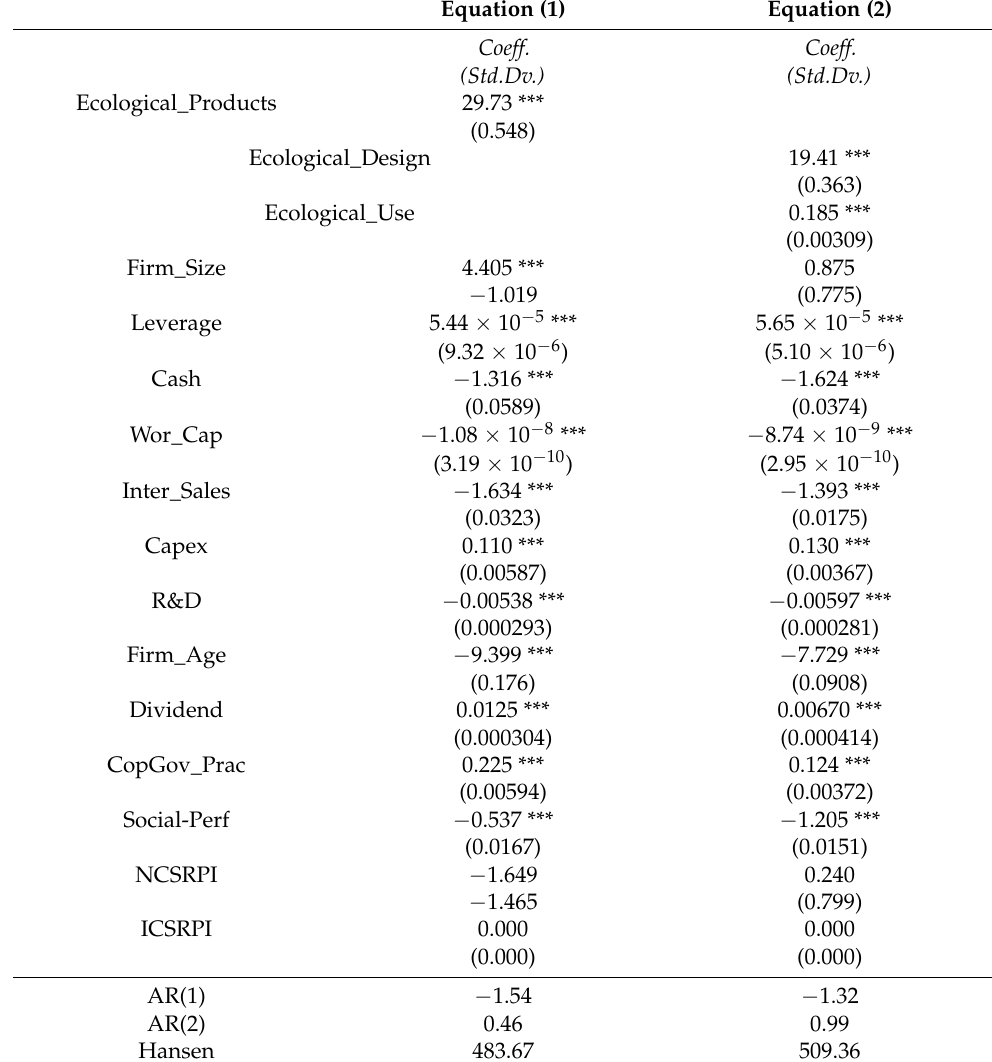
Table 4. Results of explanatory models (*** p <